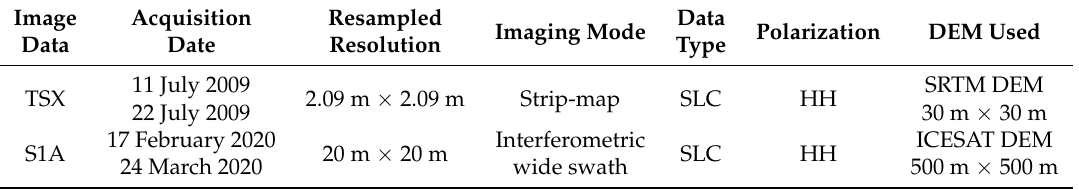
Table 1. TerraSAR-X (TSX) and Sentinel-1A (S1A) image data used in the experiments.